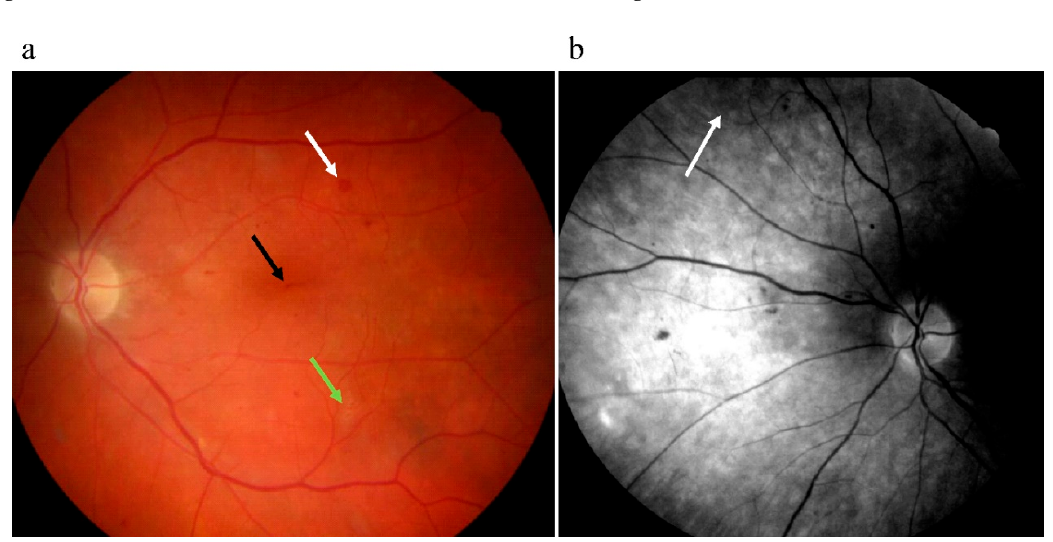
Figure 1. ( a ) Fundus photograph of donor of UTA.08203.EURCCS cell line having severe diabetes retinopathy with a microaneurysm (black arrow), hemorrhage (white arrow), and soft exudate (green arrow). ( b ) A red free fundus photograph from the same patient with intraretinal microvascular abnormalities (IRMA) pointed with an arrow.